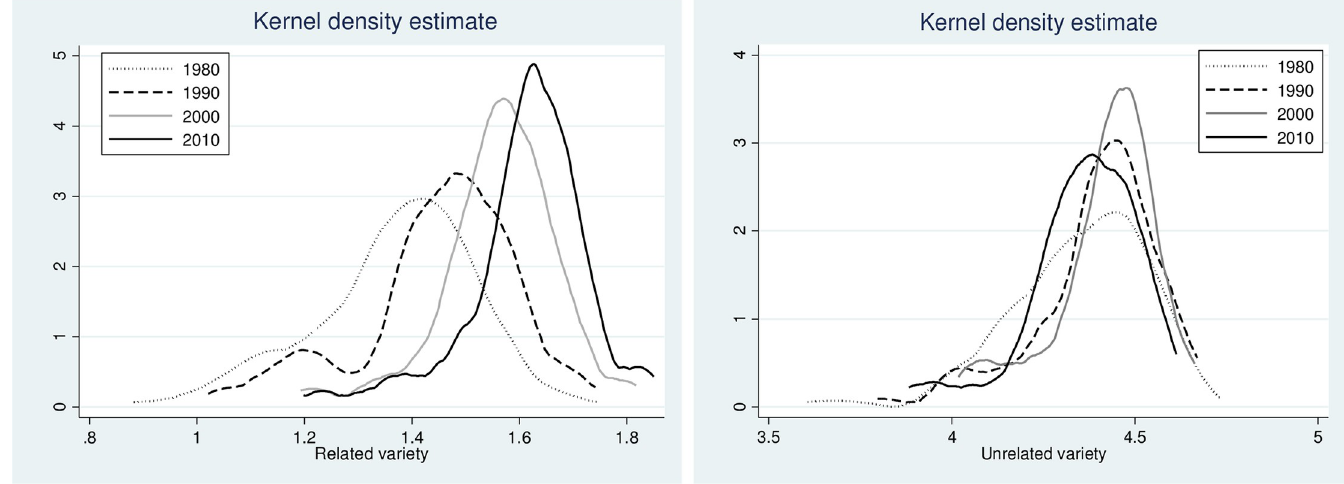
Fig 3. Probability density for related and unrelated variety. Source: Authors.